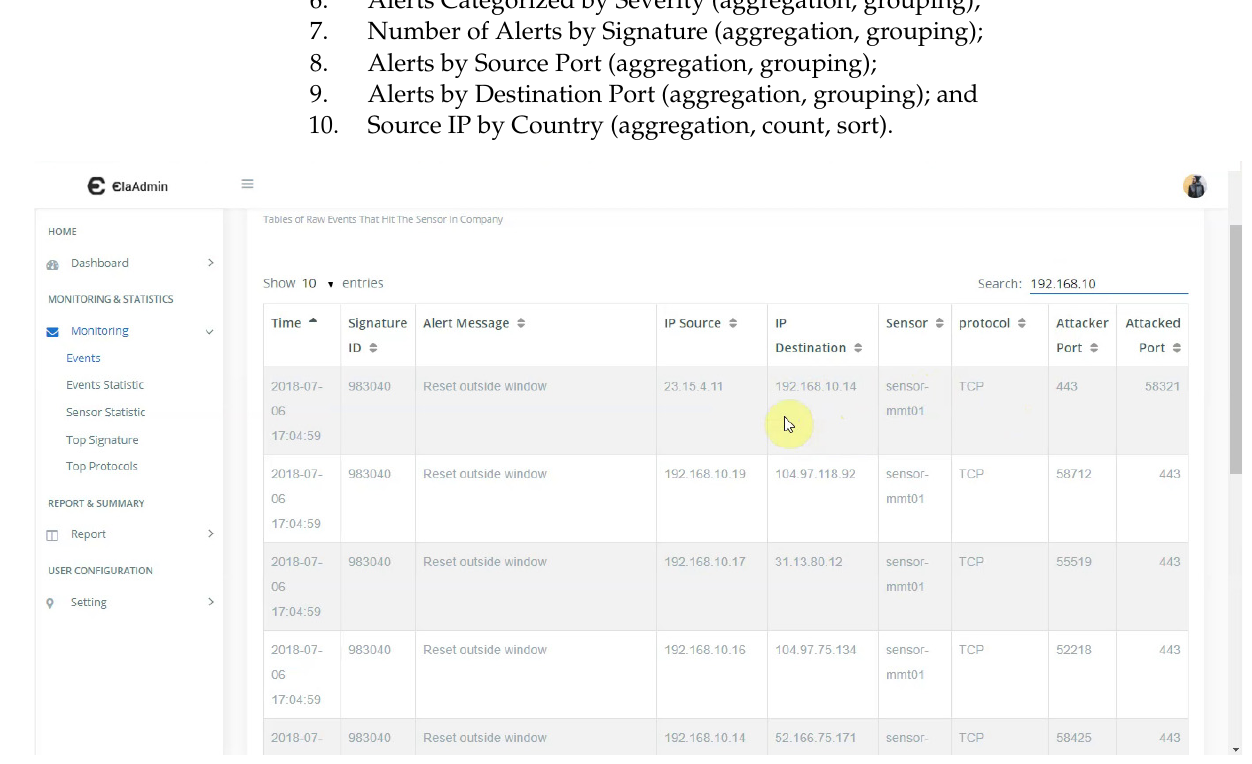
Figure 9. The dashboard shows the network security event data. The left menu contains two sub-menus: (1) Monitoring & Statistics and (2) Report & Summary.